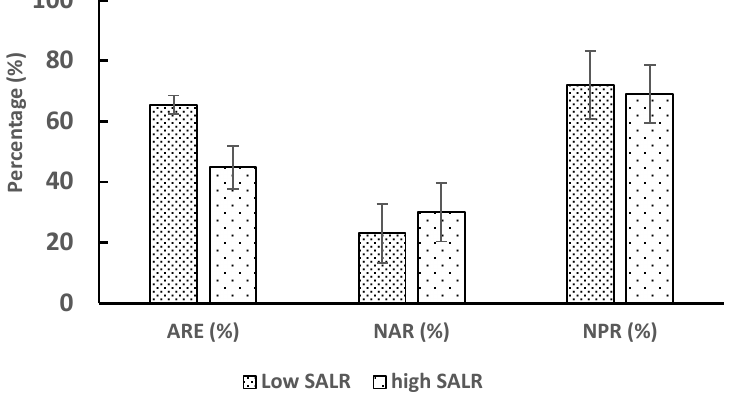
Figure 5. Effect of SALR on nitrogen compounds transformations under same DO/TAN ratio. Error bars are the standard deviations calculated from six samples.